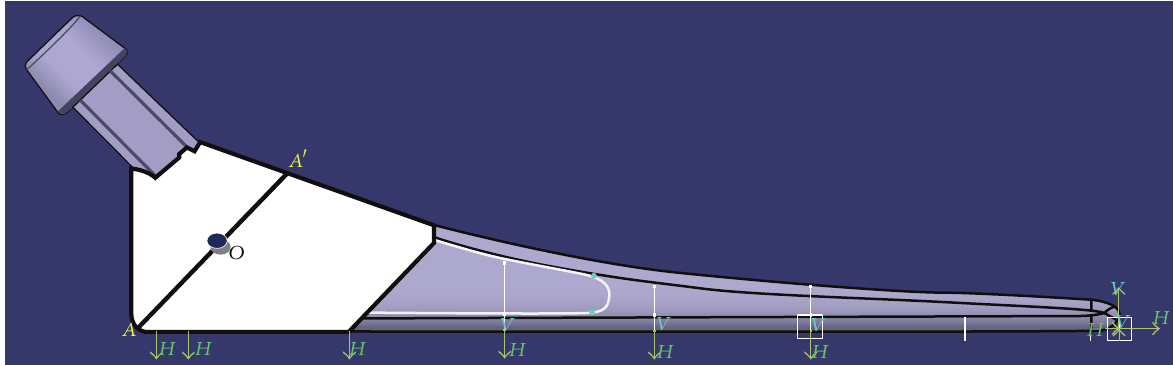
Figure 4: The designed customized hip implant [1] that is being used as the standard for our current investigation, with the demarcation of the region where porosity is going to be introduced (region of interest) shown in white.